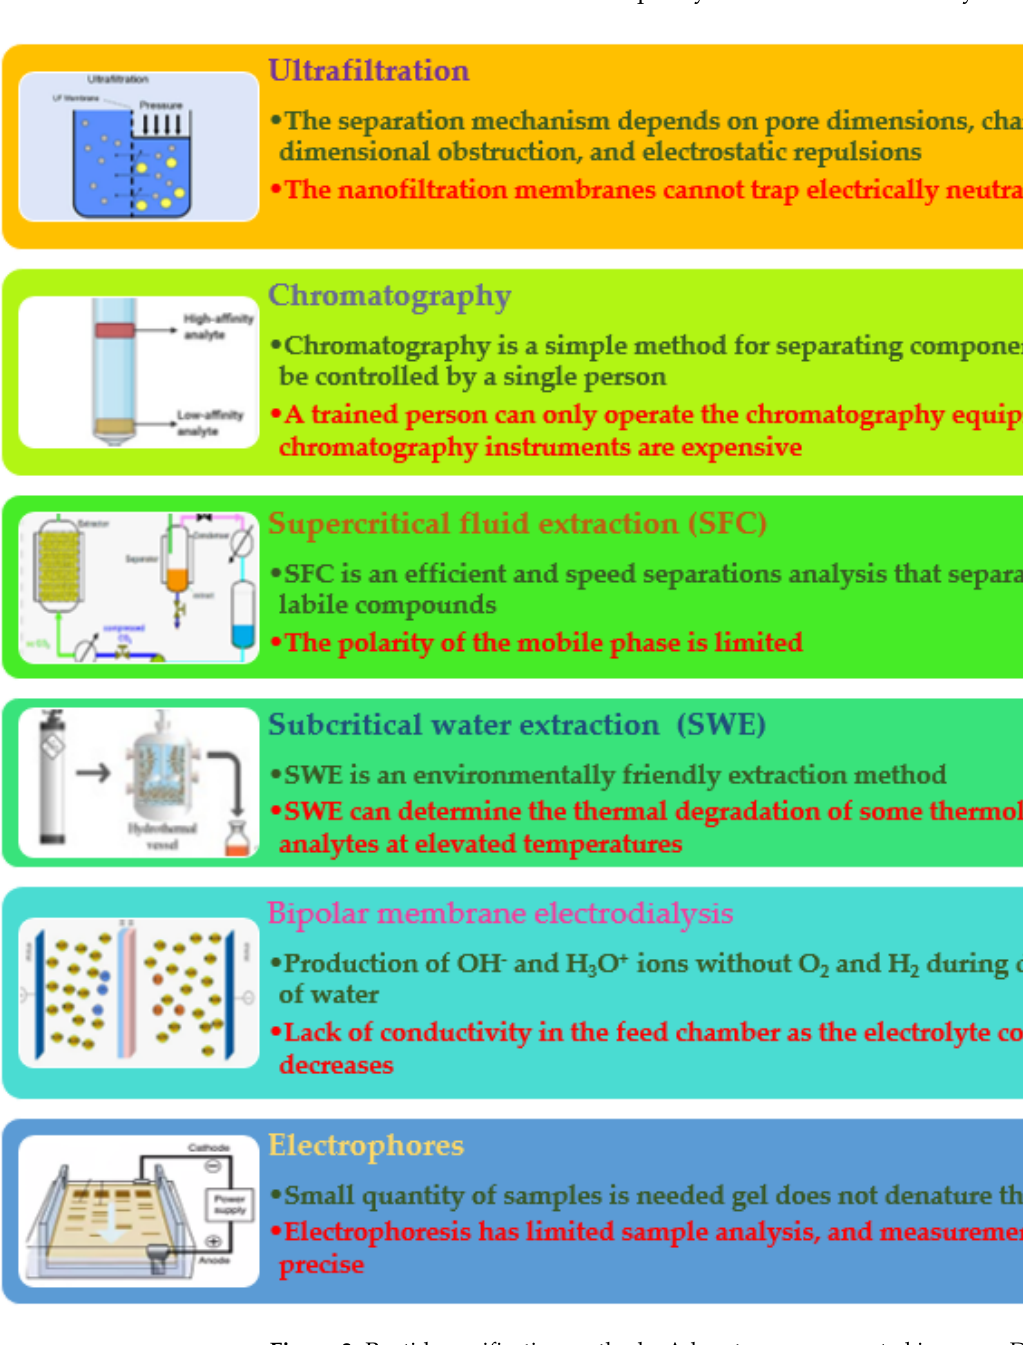
Figure 3. Peptide purification methods. Advantages are reported in green. Disadvantages are given in red.